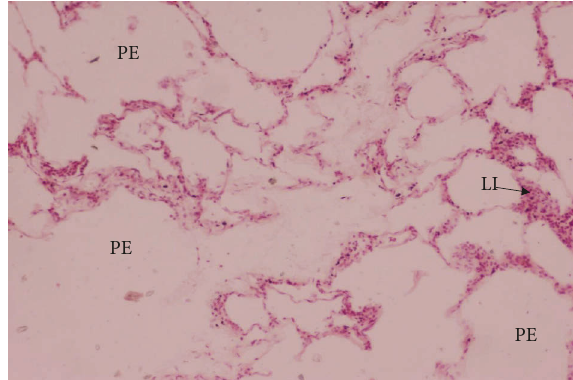
Figure 8: Lungs of goats suffering from respiratory syndrome showing pulmonary emphysema (PE) and leukocytic infiltartion (LI) suffering from Mccp (H & E